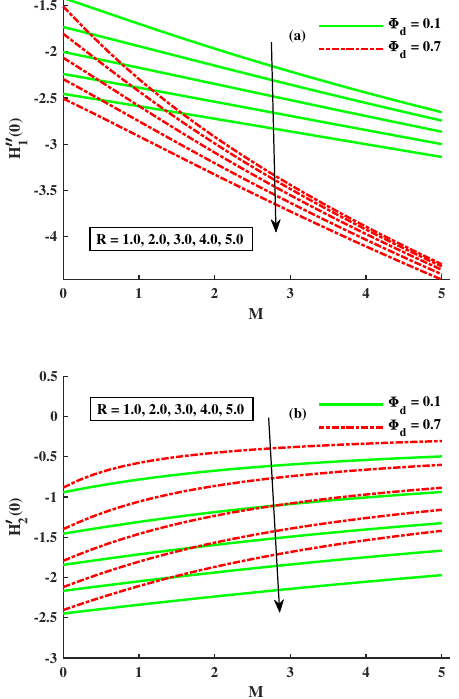
Figure 12. Influence of R , M & φ d on ( a ) H (cid:48)(cid:48)